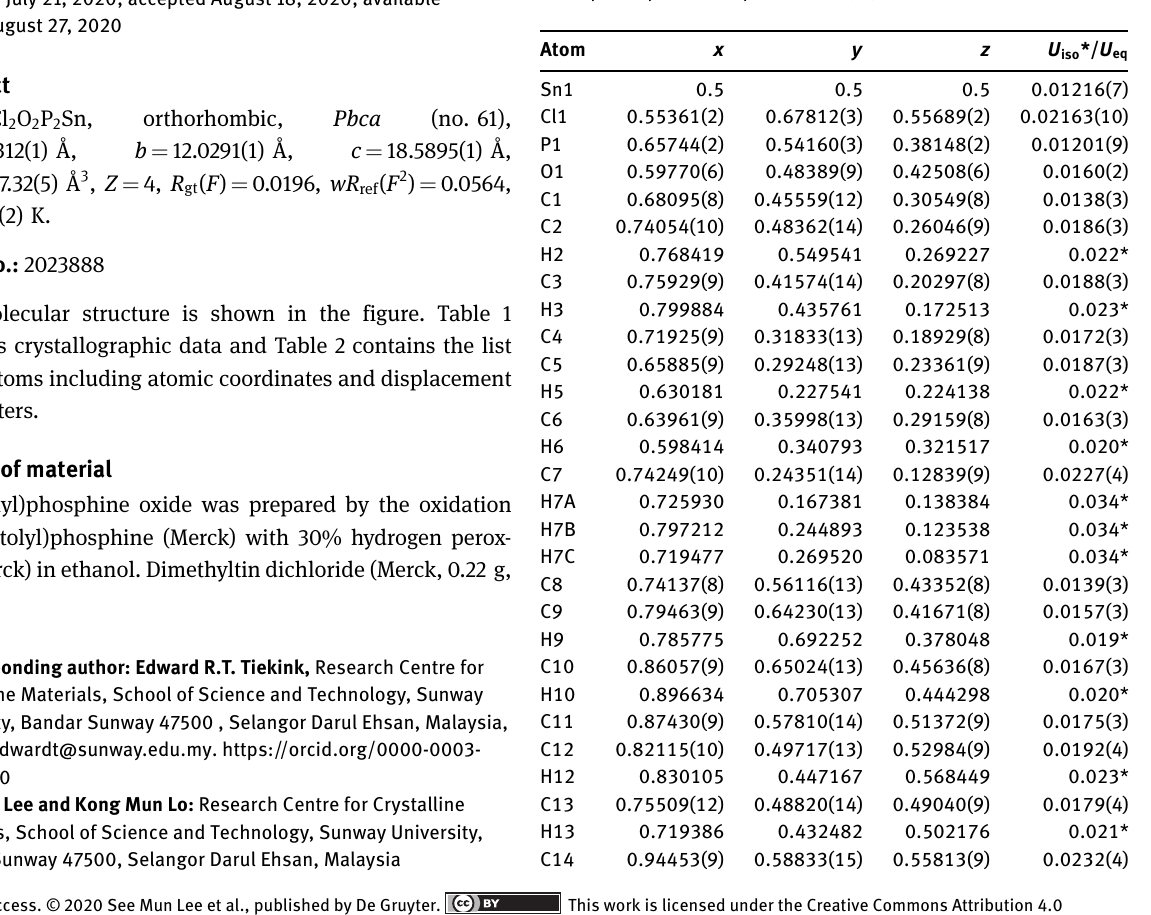
Table 2: Fractional atomic coordinates and isotropic or equivalent isotropic displacement parameters (Å 2